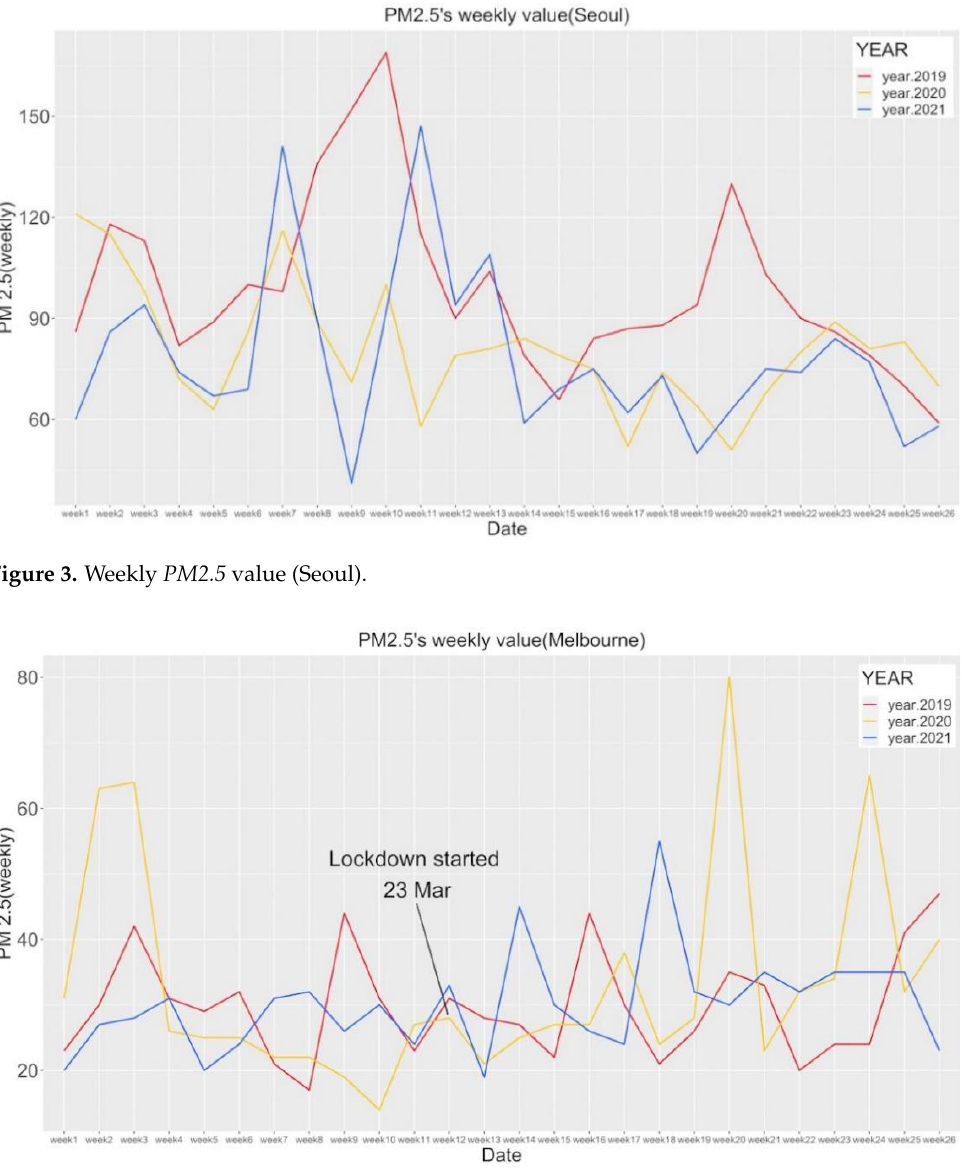
Figure 4. Weekly PM2.5 value (Melbourne).